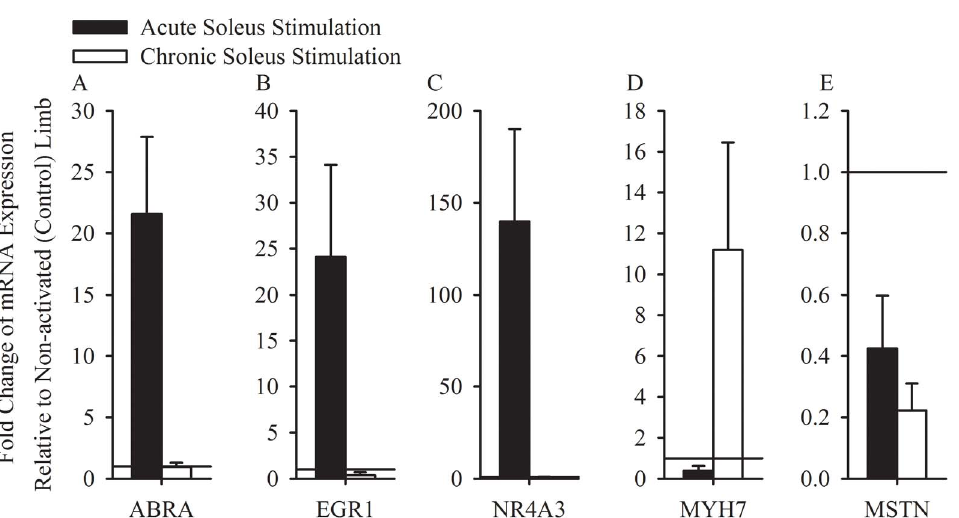
Fig. 6. Confirmatory qPCR of a subset of genes important for metabolic and hypertrophy pathways in muscle. qPCR analysis of mean ABRA (A), EGR1(B), NR4A3(C), MYH7(D), and MSTN(E) levels for acutely stimulated muscles (black) and chronically trained muscles (white). (A–E) Data represented as mean ¡ standard